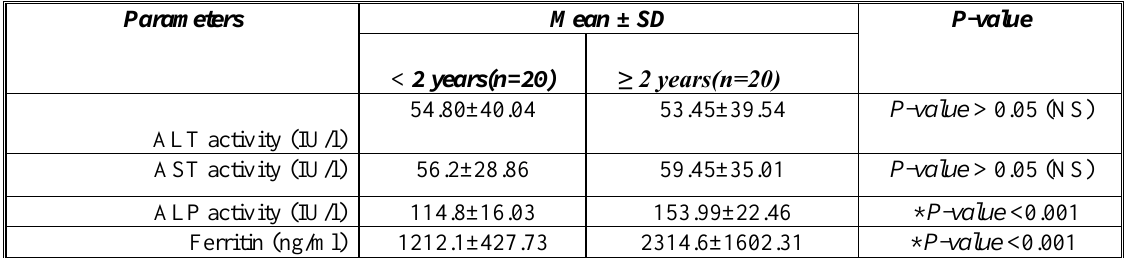
Table3. Effect of Age on Serum ALT, AST, ALP and Ferritin in Group A.